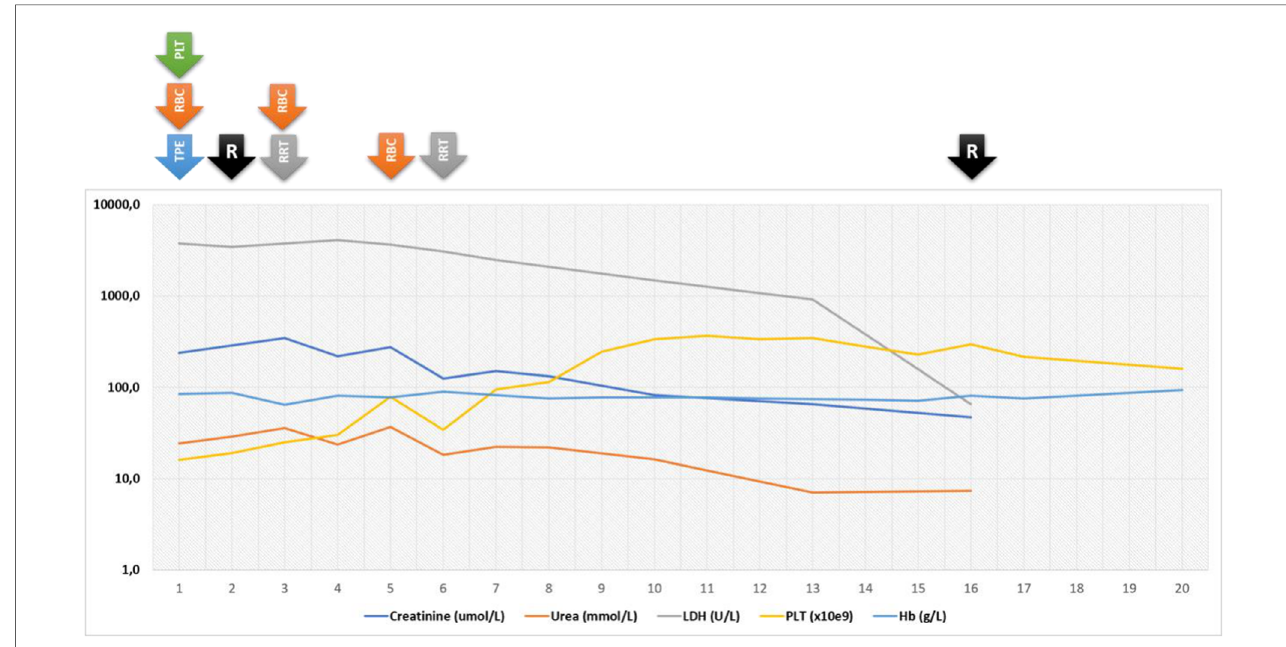
FIGURE 1 Graphical representation of laboratory values and therapeutical interventions during the course of the disease. R, ravulizumab; TPE, therapeutic plasma exchange; RBC, red blood cells; PLT,